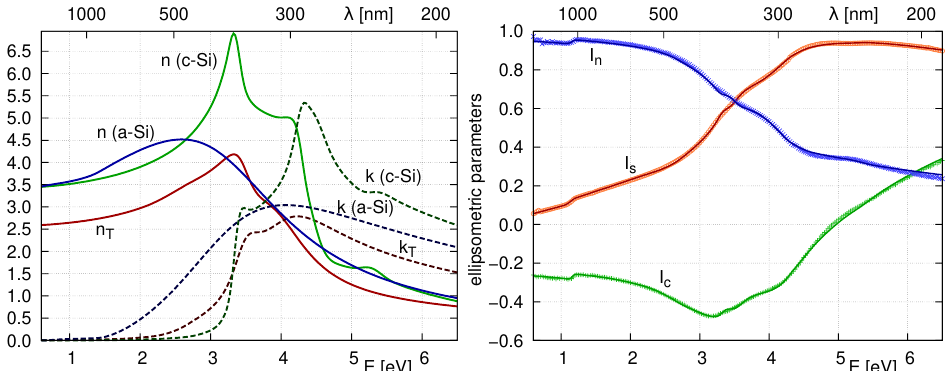
Figure 4. Spectral dependencies of the optical constants of the transition layer ( left ) and the associ- ated ellipsometric parameters measured at angle of incidence 70 ◦ on the sample pretreated in the argon discharge ( right ). The points represent the experimental values while the lines represent the theoretical